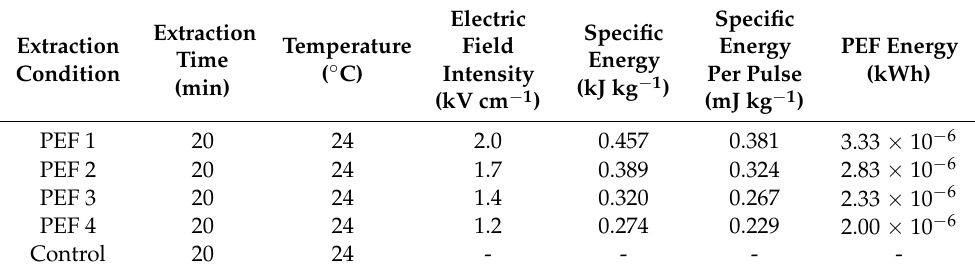
Table 1. Extraction conditions for PEF and control